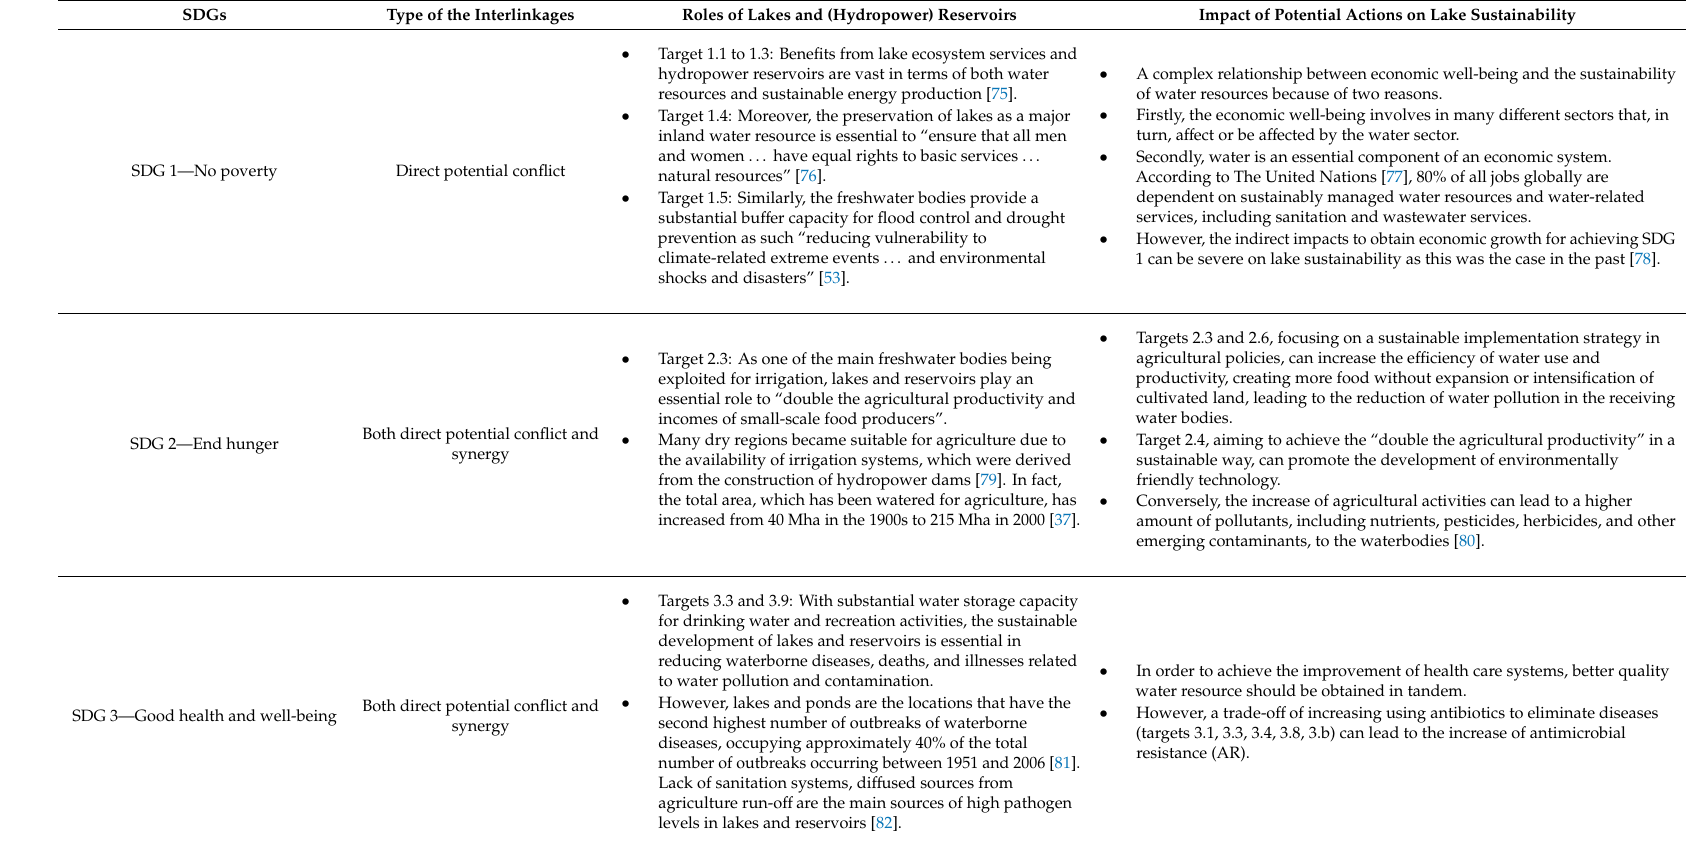
Table 1. Overview of direct interlinkages between the sustainable development of lakes and reservoirs and the